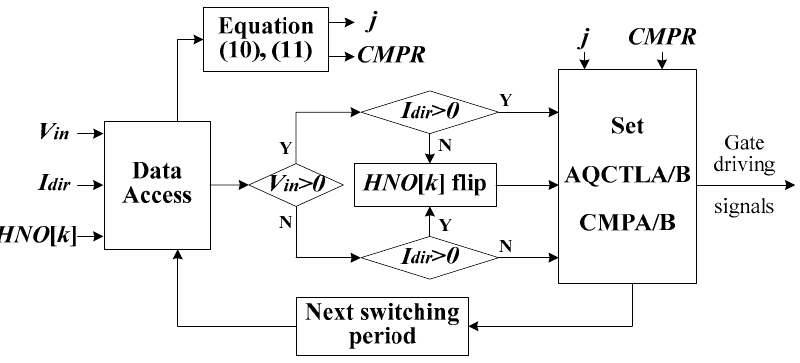
Figure 6. Implementation of improved PD ‐ PWM in DSP.